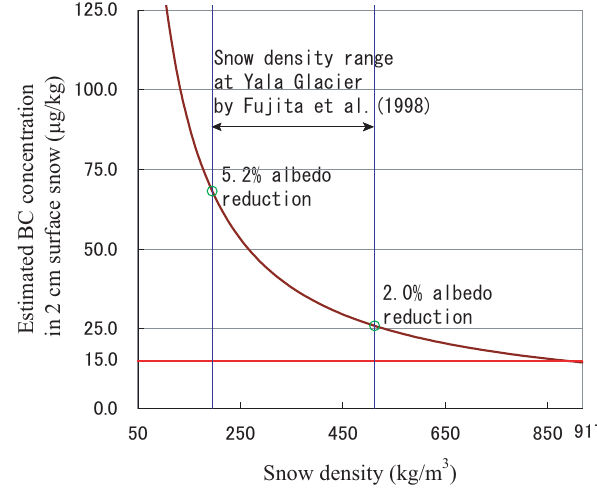
Fig. 6. The relationship between snow density and the calculated BCC in surface snow together with related albedo reductions. The brown curved and red lines denote the estimated BCD of 266µg m − 2 from NCO-P data and the 1% albedo reduction line by BCC of 15µgkg − 1 in snow mentioned in Grenfell et al. (1994) indicated by the calculations of Warren and Wiscombe (1980). The range be- tween two blue solid lines corresponds to the range of snow density variations of 195–512kgm − 3 in surface snow at Yala glacier by Fujita et al. (1998). The green circles are estimated maximal and minimal albedo reductions due to BCC in snow by using a linear regression equation of Ming et al.